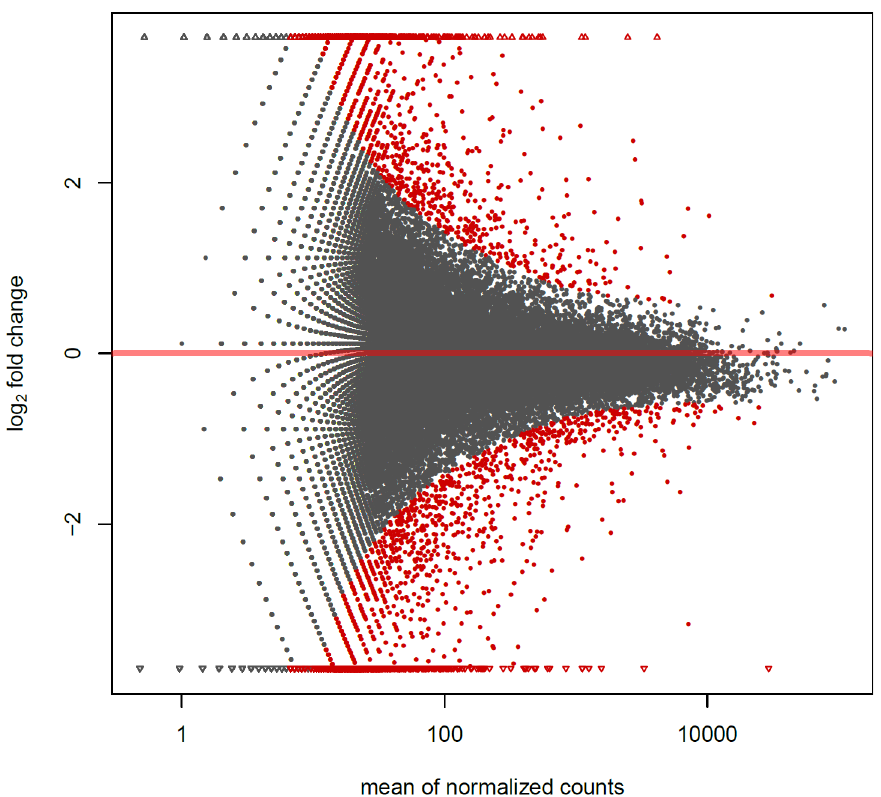
Fig 2. Difference of unigene expression between male (XY) and super-male (YY). The X-axis represents the value of normalized expression counts, and the Y-axis represents the level of differential expression. Significantly differential expressions are marked in red and other in